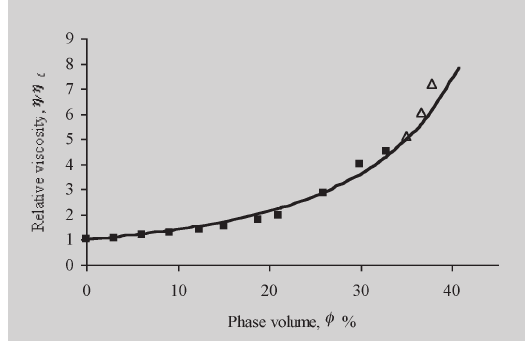
Figure 1: Relative viscosity as a func- tion of phase volume for a 65mm glass-bead suspen- sion in capillary tubes (solid squares) adjusted using a Mooney-type correction; in a concentric-cylinder vis- cometer (open triangles) with no correction and a plot of the Maron-Pierce- Quemada-Kitano equation with fm = 0.635 (solid